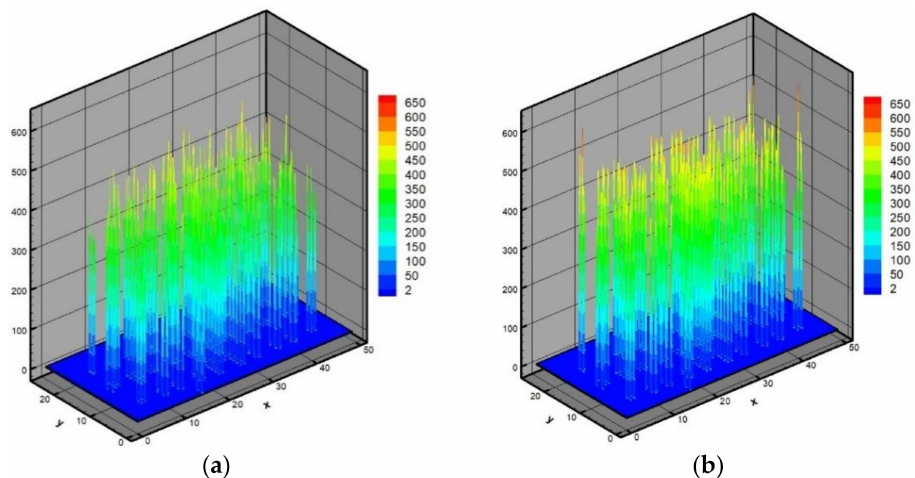
Figure 10. Bearing capacity of piles in December 2020 ( a ) and in February 2021 ( b ) in tf/m 2 .